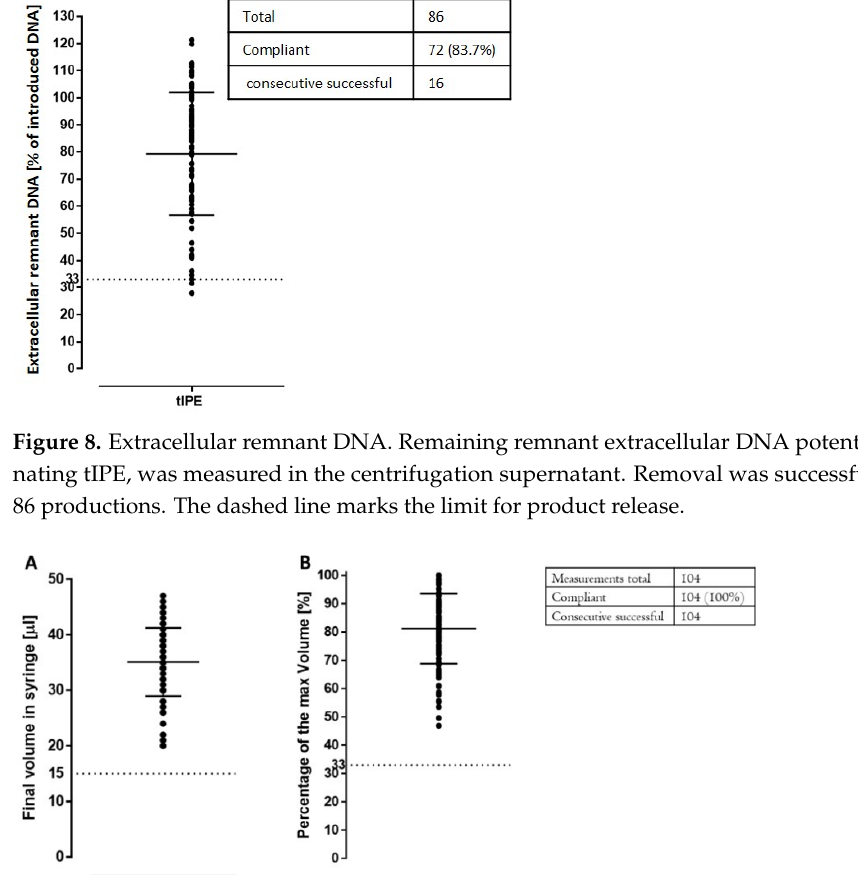
Figure 9. Volume of tIPE. ( A ) illustrates the volume of tIPE in microliter, and ( B ) shows the volume in percentage of the maximal volume. The dashed line marks the minimum volume for product release.